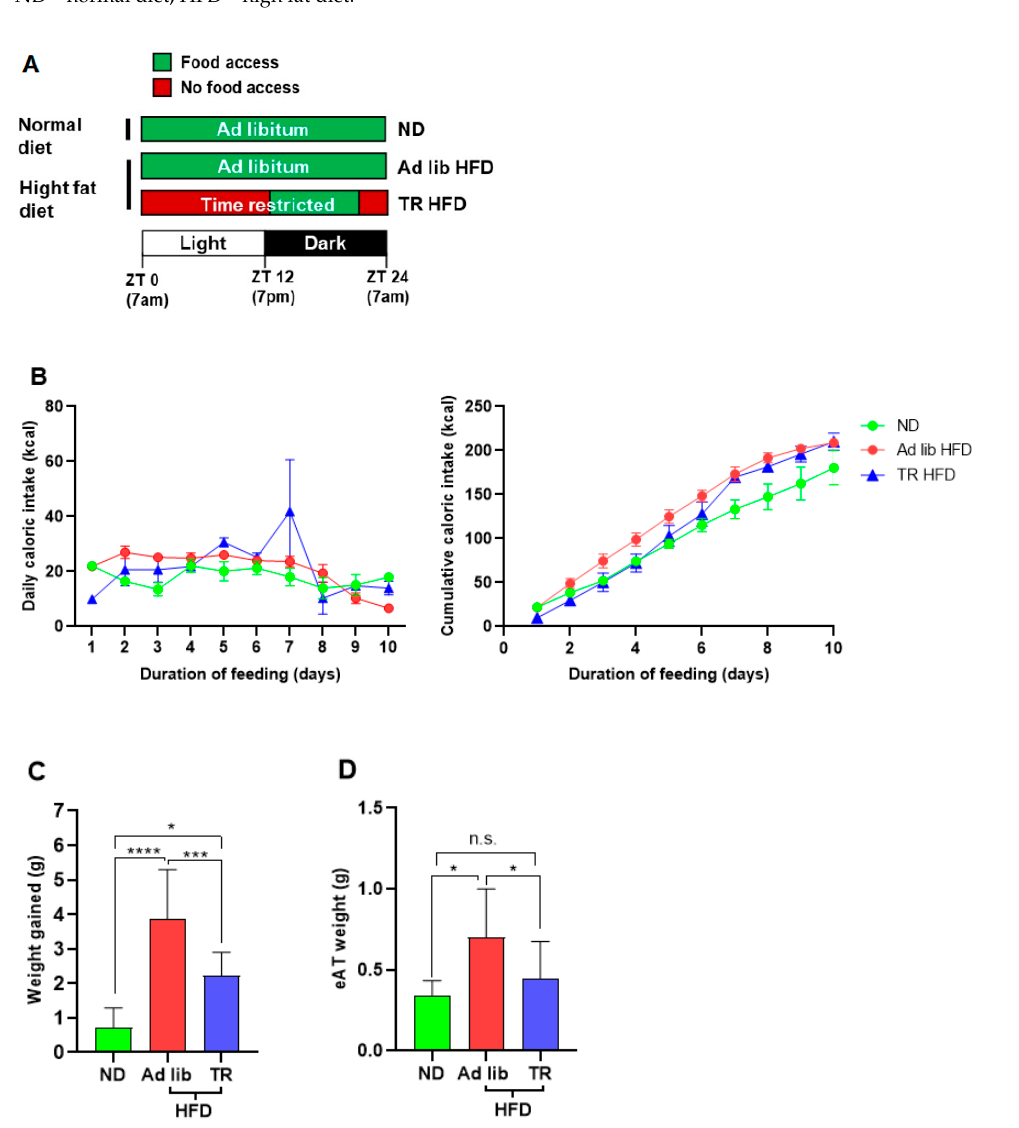
Figure 1. Time-restricted feeding attenuated body weight gain and adiposity. ( A ) Schematic representation of the different feeding regimens. TR HFD fed mice were allowed access to food from 8 p.m. (ZT13) through 4 a.m. (ZT21). ( B ) Caloric intake in ND, ad libitum HFD, and TR HFD fed mice. Left: average daily caloric intake. Right: Cumulative average caloric intake over the 10-day experimental feeding period. ( C ) Body weight gain and ( D ) visceral adiposity (eAT) in ND, ad libitum HFD, and TR HFD fed mice. ND—normal diet; TR—time-restricted; HFD—high fat diet; n.s.—not significant; * p ≤ 0.05; *** p ≤ 0.001; **** p ≤ 0.0001. Table 2. Body composition and adipose tissue (eAT) immune cells of HFD fed mice.